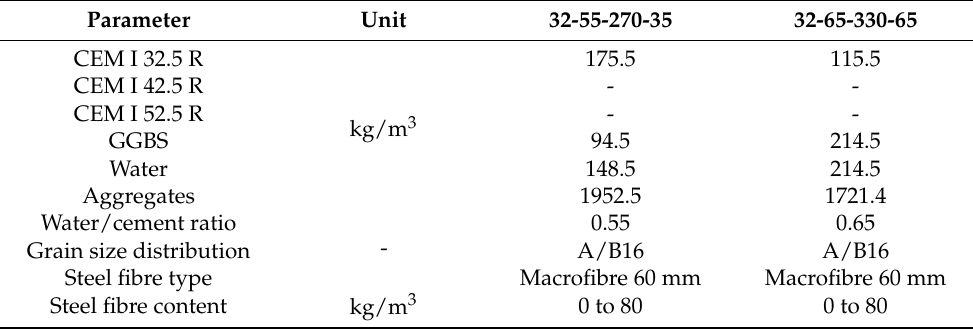
Table A6. Concrete mix designs for the multiple parameter variation—part 1.